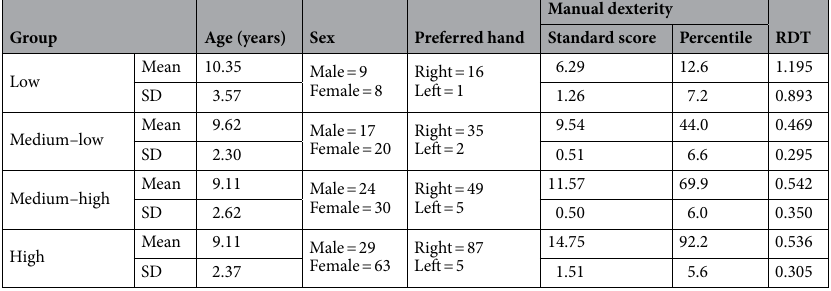
Table 3. Summary of data for each manual dexterity group. RDT action-outcome regularity detection threshold, SD standard deviation.